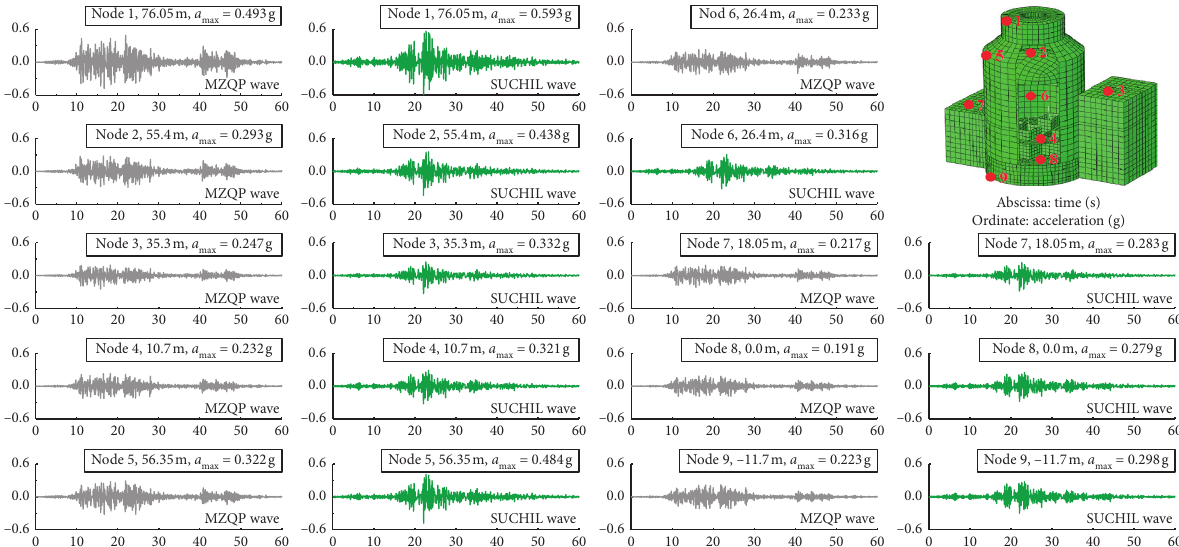
Figure 8: Acceleration response of the nuclear island structure observation